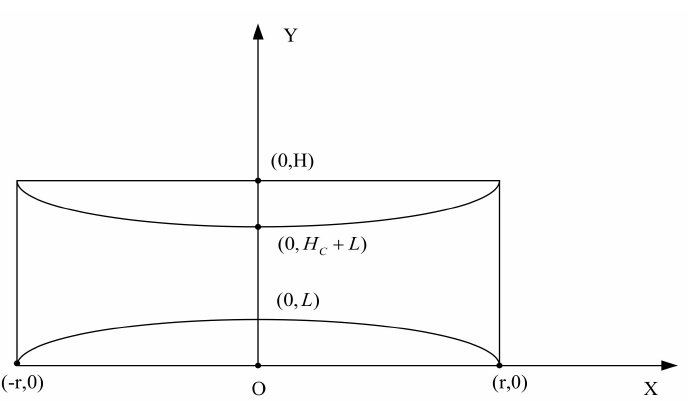
Figure 2. Identical paraboloid-shaped net